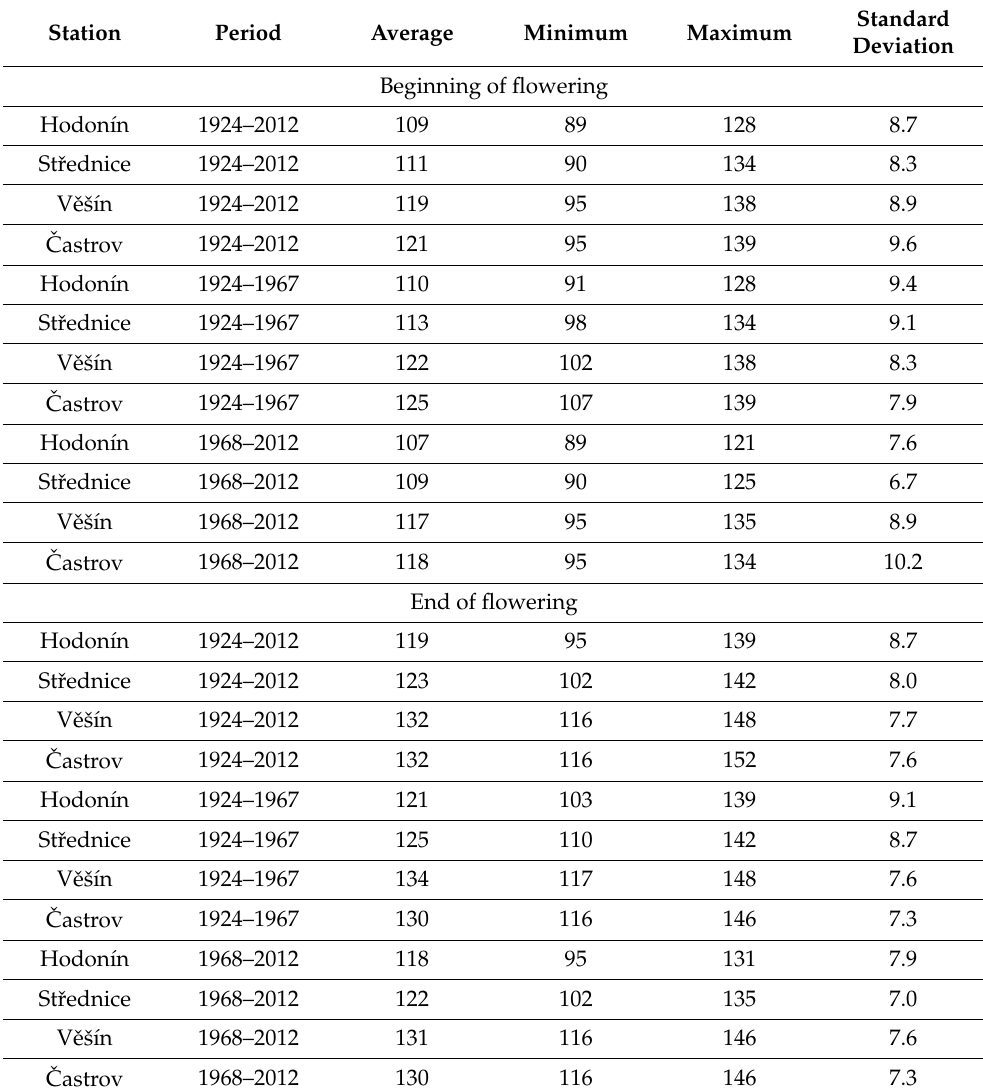
Table 3. Descriptive statistics for the beginning of flowering and end of flowering of Cerasus avium